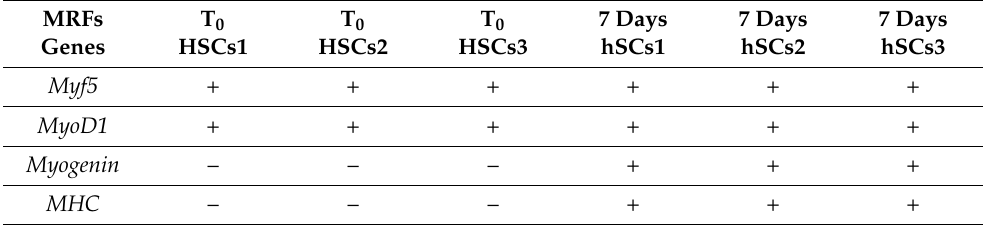
Table 1. RT-PCR analysis of myogenic differentiation marker genes. RT-PCR analysis showed the different expression of Myf5, MyoD1, Myogenin , and of MHC , analyzed over time during myogenic differentiation of three primary hSC lines (hSCs1, hSCs2, hSCs3). MRFs T 0 T 0 T 0 7 Days Genes HSCs1 HSCs2 HSCs3 hSCs1 hSCs2 hSCs3 Myf5 + MyoD1 + + + + + + Myogenin – – – + + + MHC – – – + + + 2.3. Analysis of CaSR Gene Expression in Human Skeletal Muscle Tissues (hSMts) and in the Derived Human Satellite Cell (hSC) Lines and during In Vitro Myogenesis We performed qualitative RT-PCR using different pairs of primers that target exons 2/3, 4/5, and 6/7 of the human CaSR gene (Table 2). CaSR mRNA expression was neither